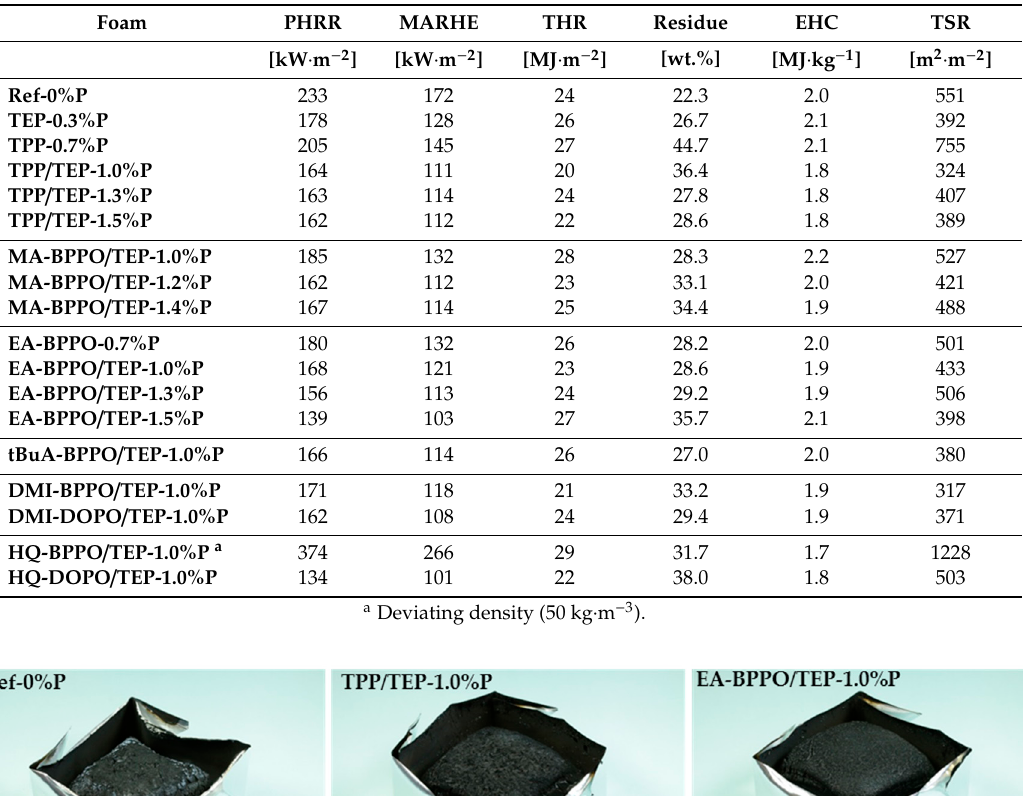
Table 7. Results of cone calorimeter tests on the PIR foams under study (heat flux 50 kW · m − 2 ).